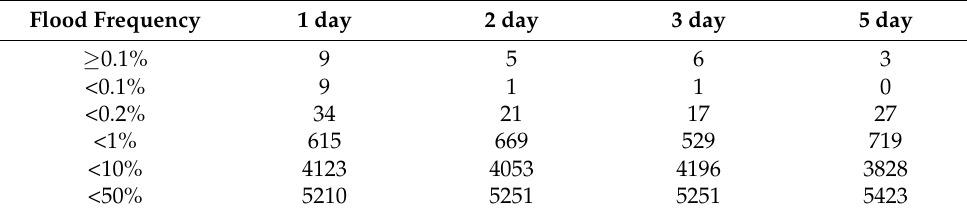
Table 2. Classification of simulated 10,000 forecast floods based on design flood frequency statistics, represented by the number of flood events that occur of different